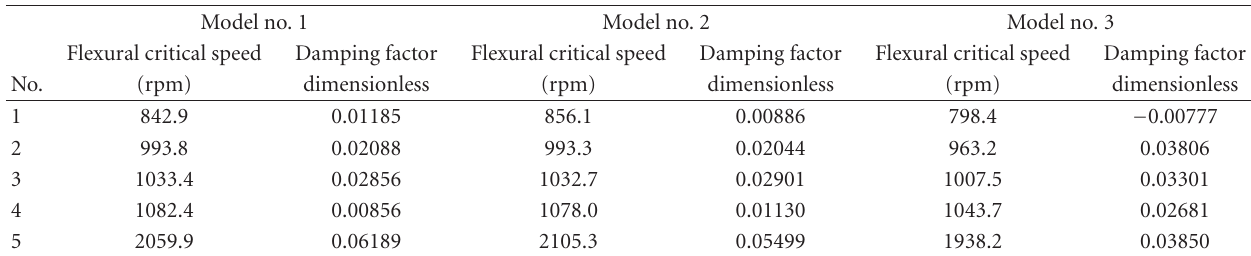
Table 3: First five flexural critical speeds and dimensionless modal damping factors of the machine-train evaluated at 3000 rpm by means of the models no. 1, no. 2, and no. 3.